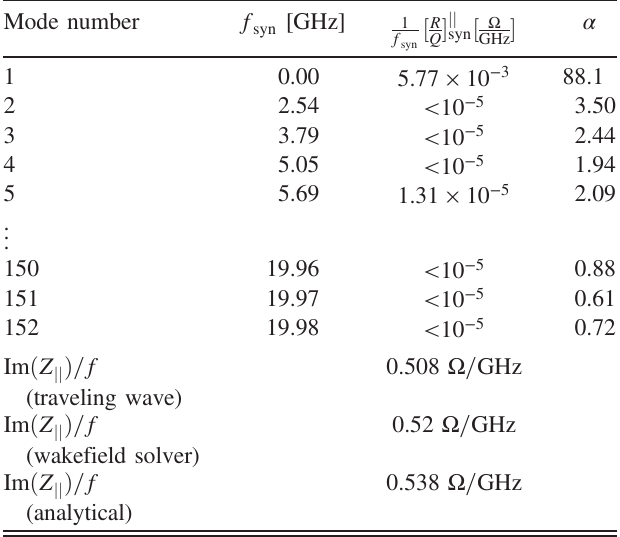
TABLE III. Longitudinal traveling wave data for one period of the circular pipe structure depicted in Fig. 5. The final result for Im ð Z jj Þ =f is the sum of the elements of the third column weighted with the corresponding factors α . The results of the wakefield solver and the analytical formula are also shown for comparison.